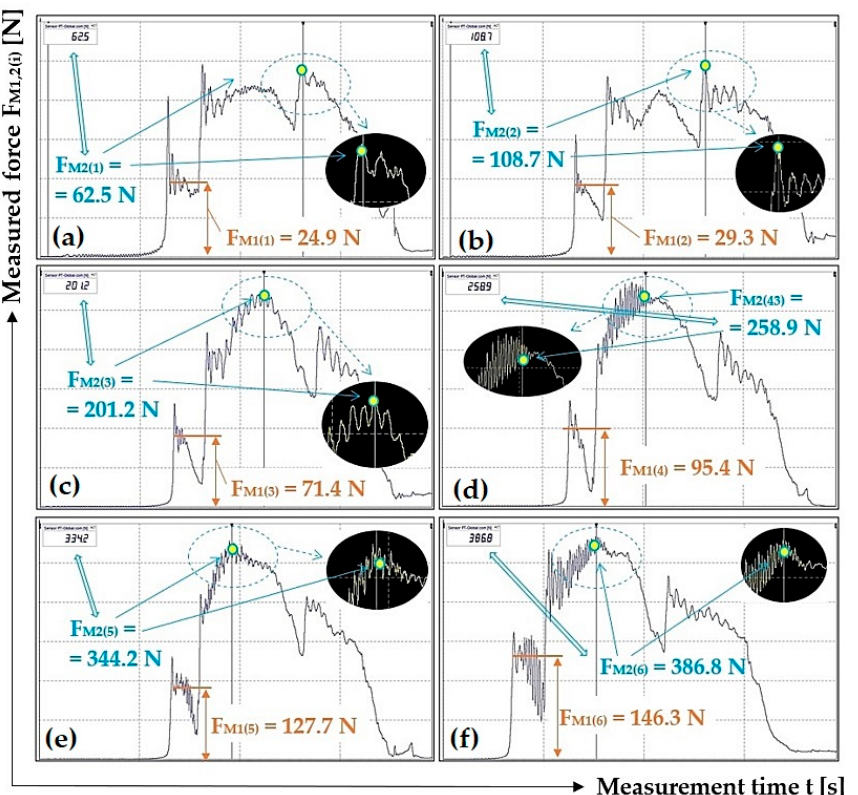
Figure 9. Tensile forces measured using DeweSoft ® software for different load weights at the scraper plough angle of inclination β = 40 deg.